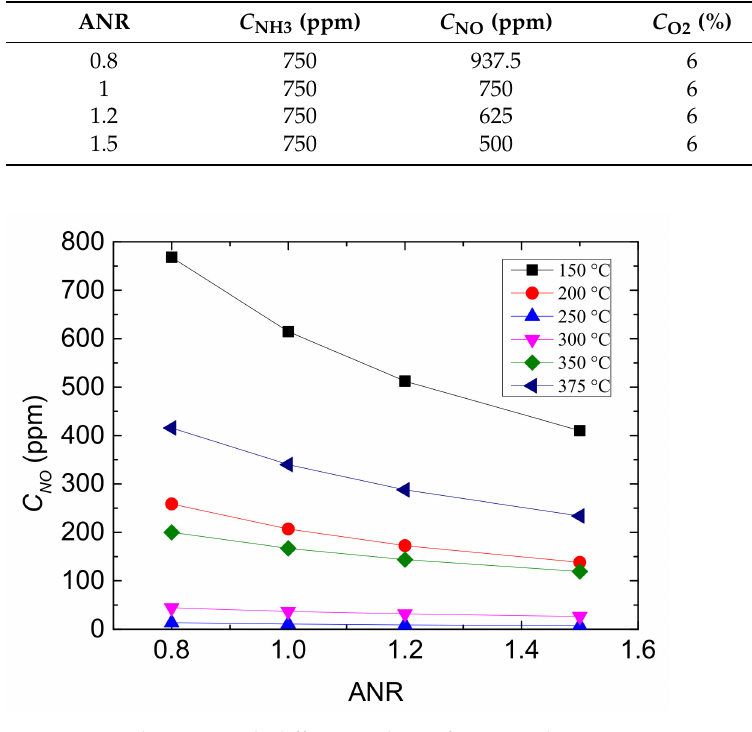
Figure 7. Outlet C NO with different values of ANR and reaction temperatures.